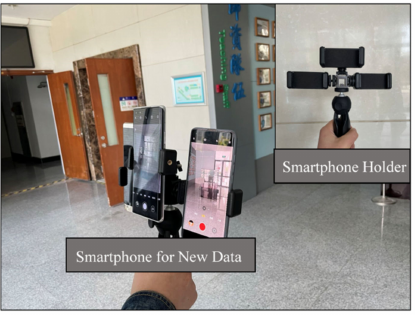
Figure 12. The new sequences collection using the